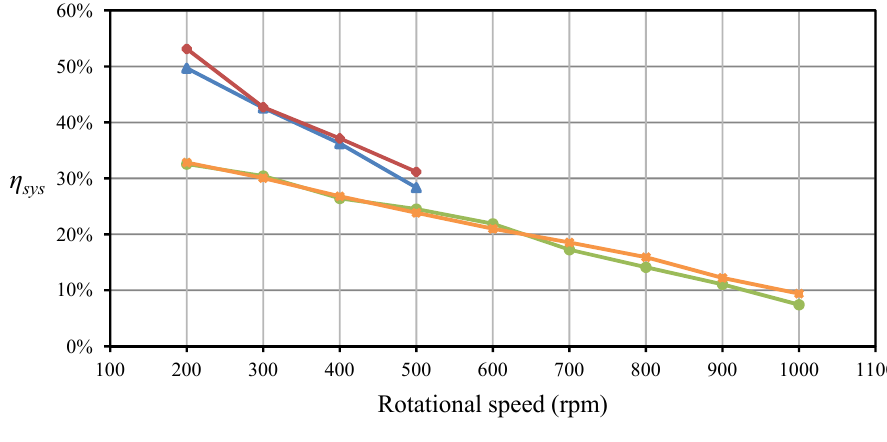
Figure 17. The comparison of theoretical and experimental